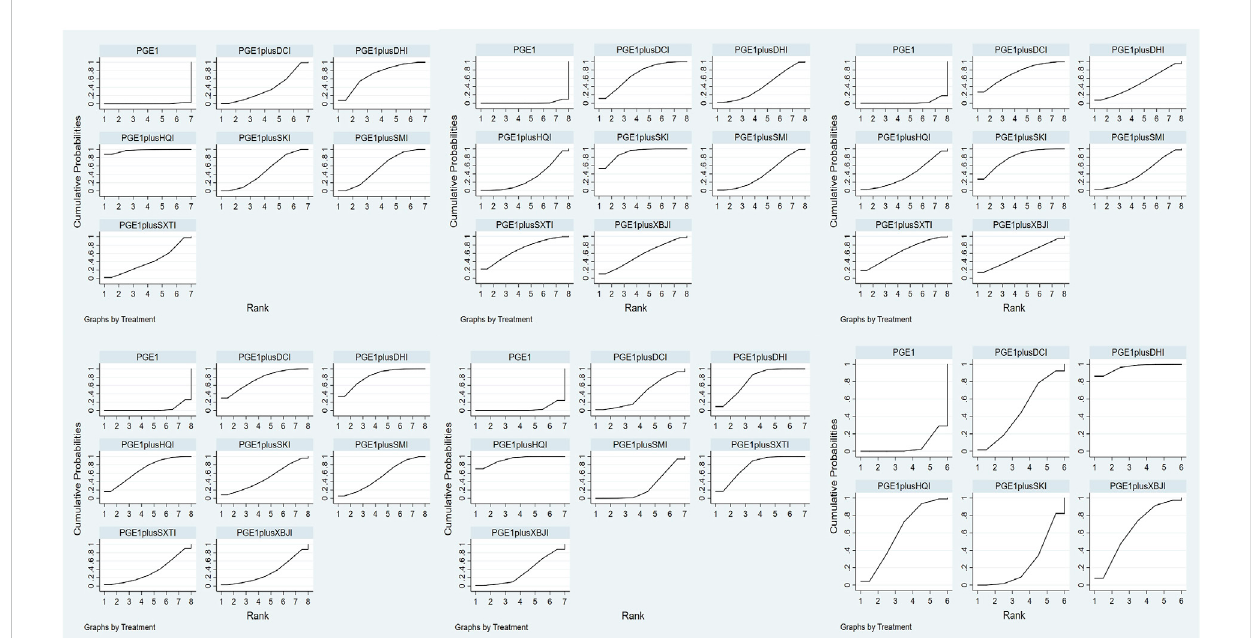
FIGURE 3 Plot of the surface under the cumulative ranking